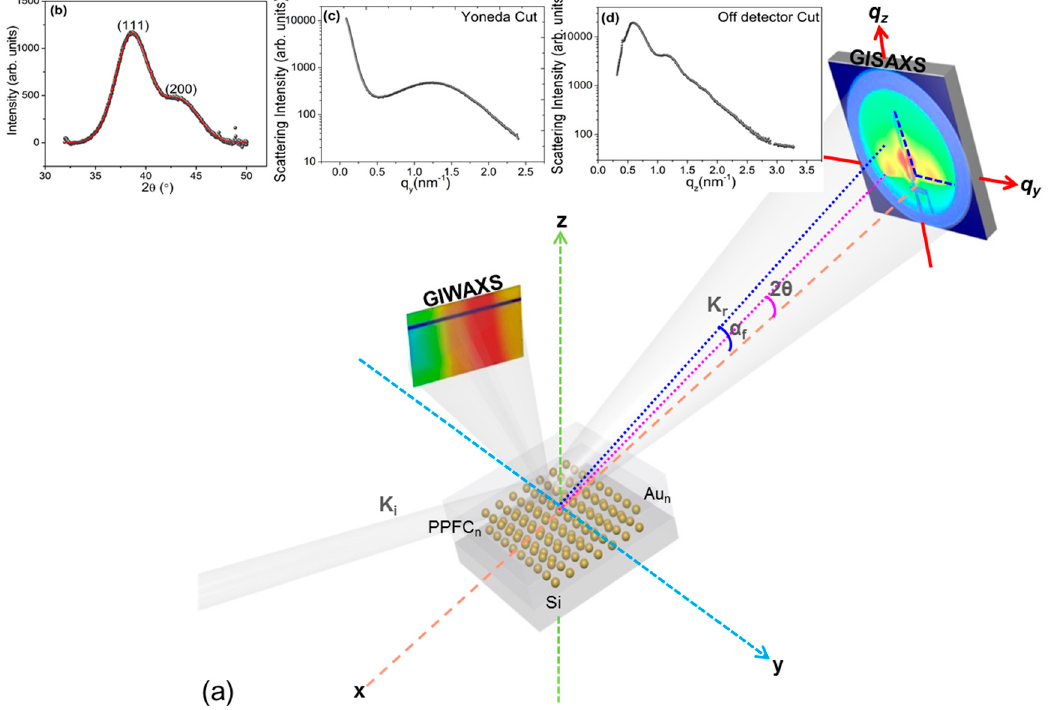
Figure 1. ( a ) Schematic view of the GISAXS experiment combined with in-plane-GIWAXS; ( b ) the extracted 1D GIWAXS profile was taken as line cut as indicated in the 2D GIWAXS image, ( c ) Yoneda cut ( q y = 0.236) and ( d ) off-detector cut (along q z ) as indicated by blue dashed lines in the 2D GISAXS pattern. In the GISAXS pattern, the origin of the coordinates of q y and q z is indicated by the direct beam position.